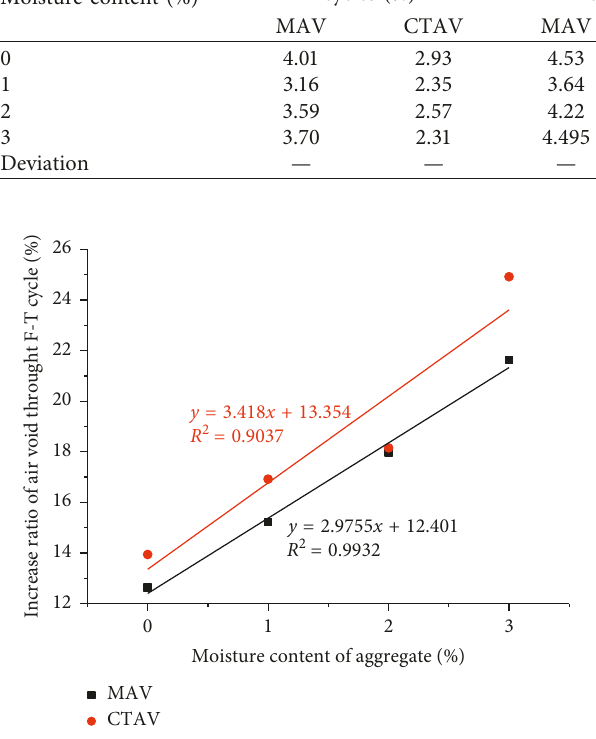
Table 11: The increase ratio of air voids of RH-WMA samples through freeze-thaw cycles. Moisture content